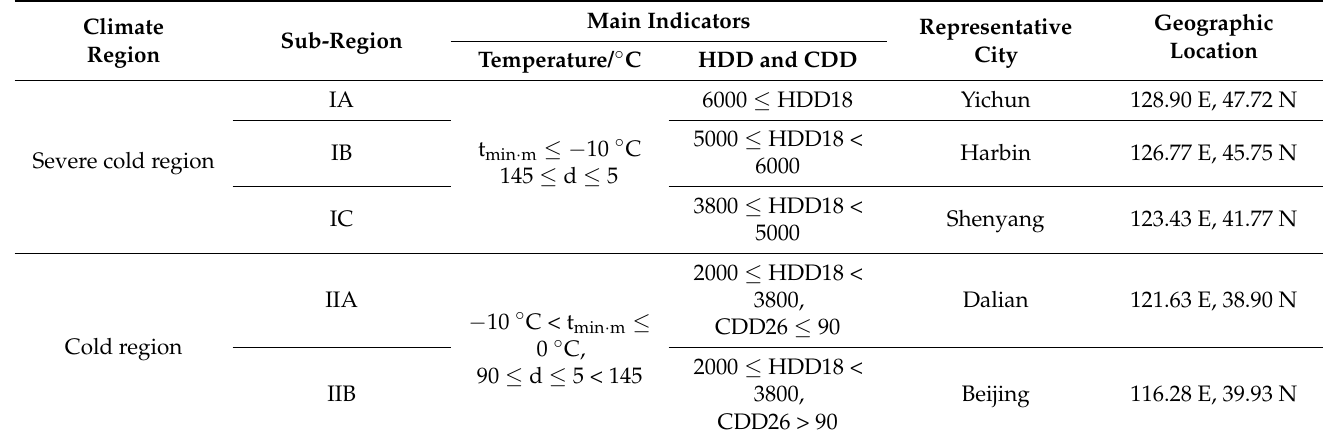
Table 3. Representative cities of the severe cold and cold regions.